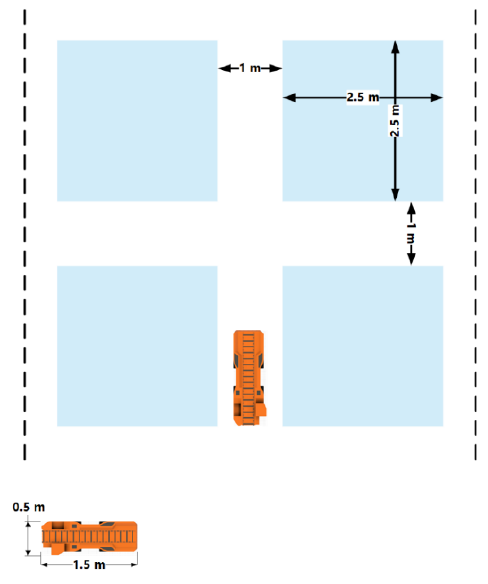
Figure 2. Plan of simulated room and pillar layout.